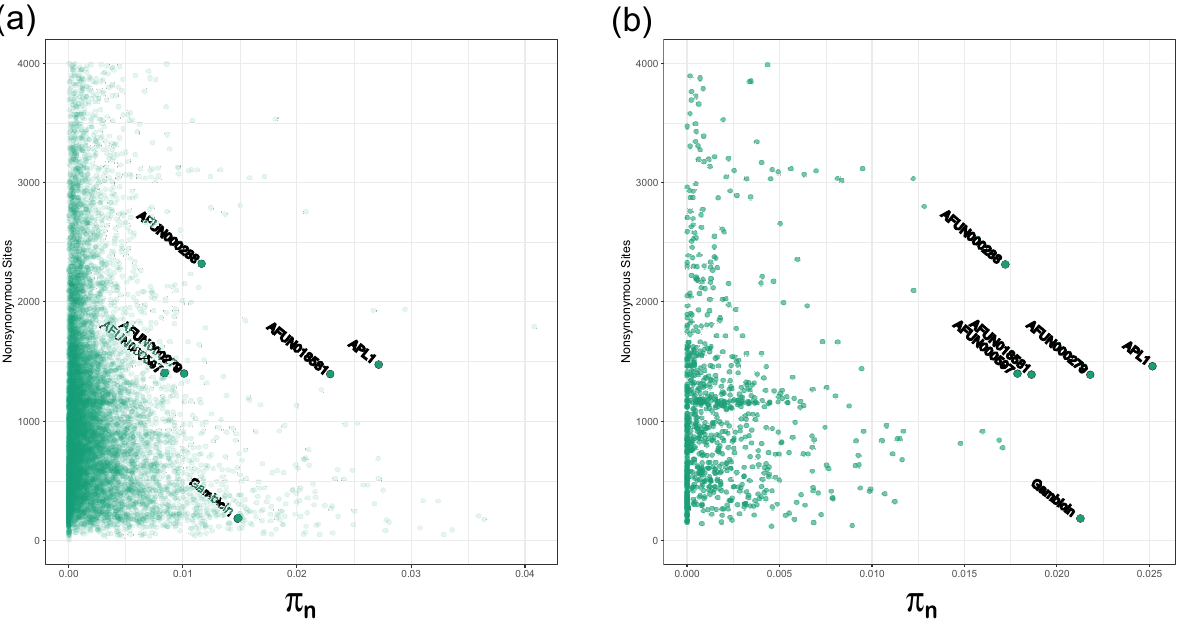
Figure 1. Anopheles funestus APL1 ( AFUN018743 ) is an outlier in non-synonymous diversity . Number of non-synonymous sites versus π N for all genes ( a ). PoolSeq data and a selection of potentially resistance associated loci; ( b ). SureSelect data. APL1 paralogues also have high π N relative to other genes, but to a lesser extent and with more variability between data types. The anti-microbial gene gambicin ( AFUN006611 ) is also labelled. Table 1. Diversity estimates for APL1 and paralogues in An. funestus .